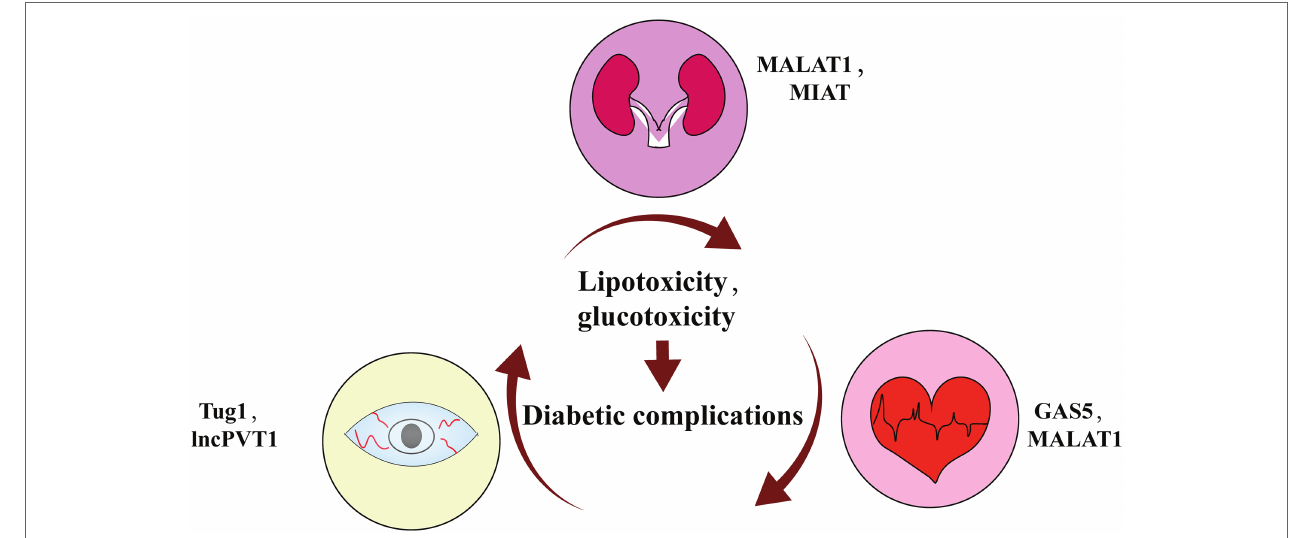
FIGURE 4 | Summary of key roles of lncRNAs in diabetic